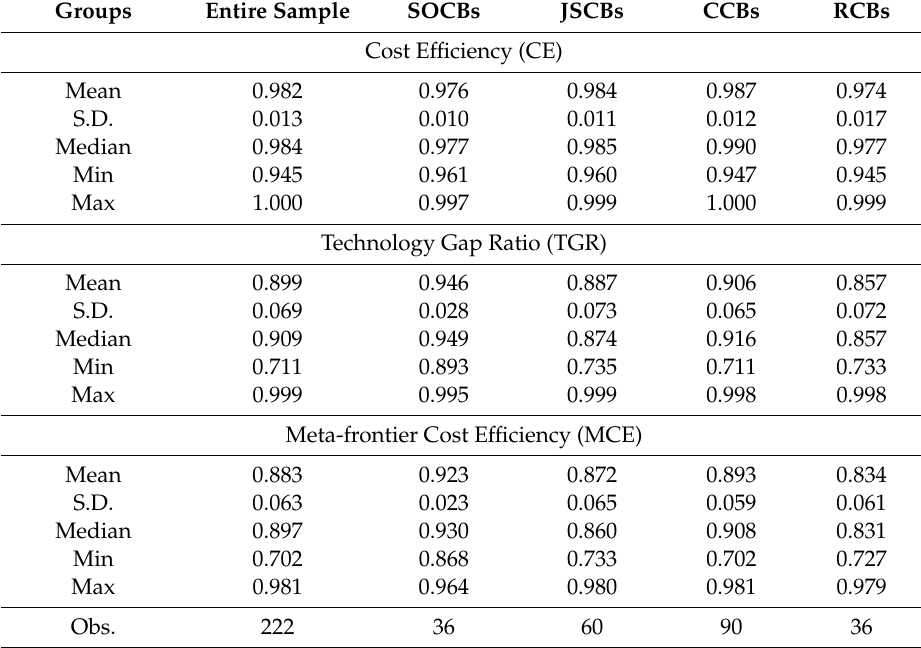
Table 6. Summary statistics of Cost E ffi ciency, Technology Gap Ratio, and Meta-frontier Cost E ffi ciency.